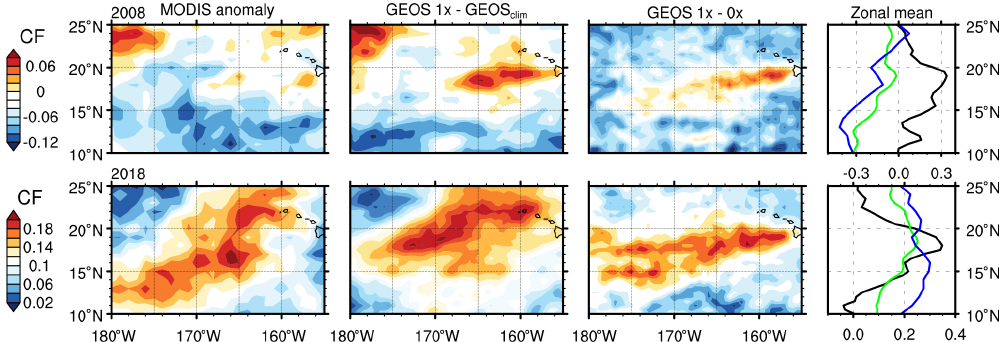
Figure 3. Like Fig. 2 but showing CF anomalies during JJA 2008 (top panels) and MJJ 2018 (bottom